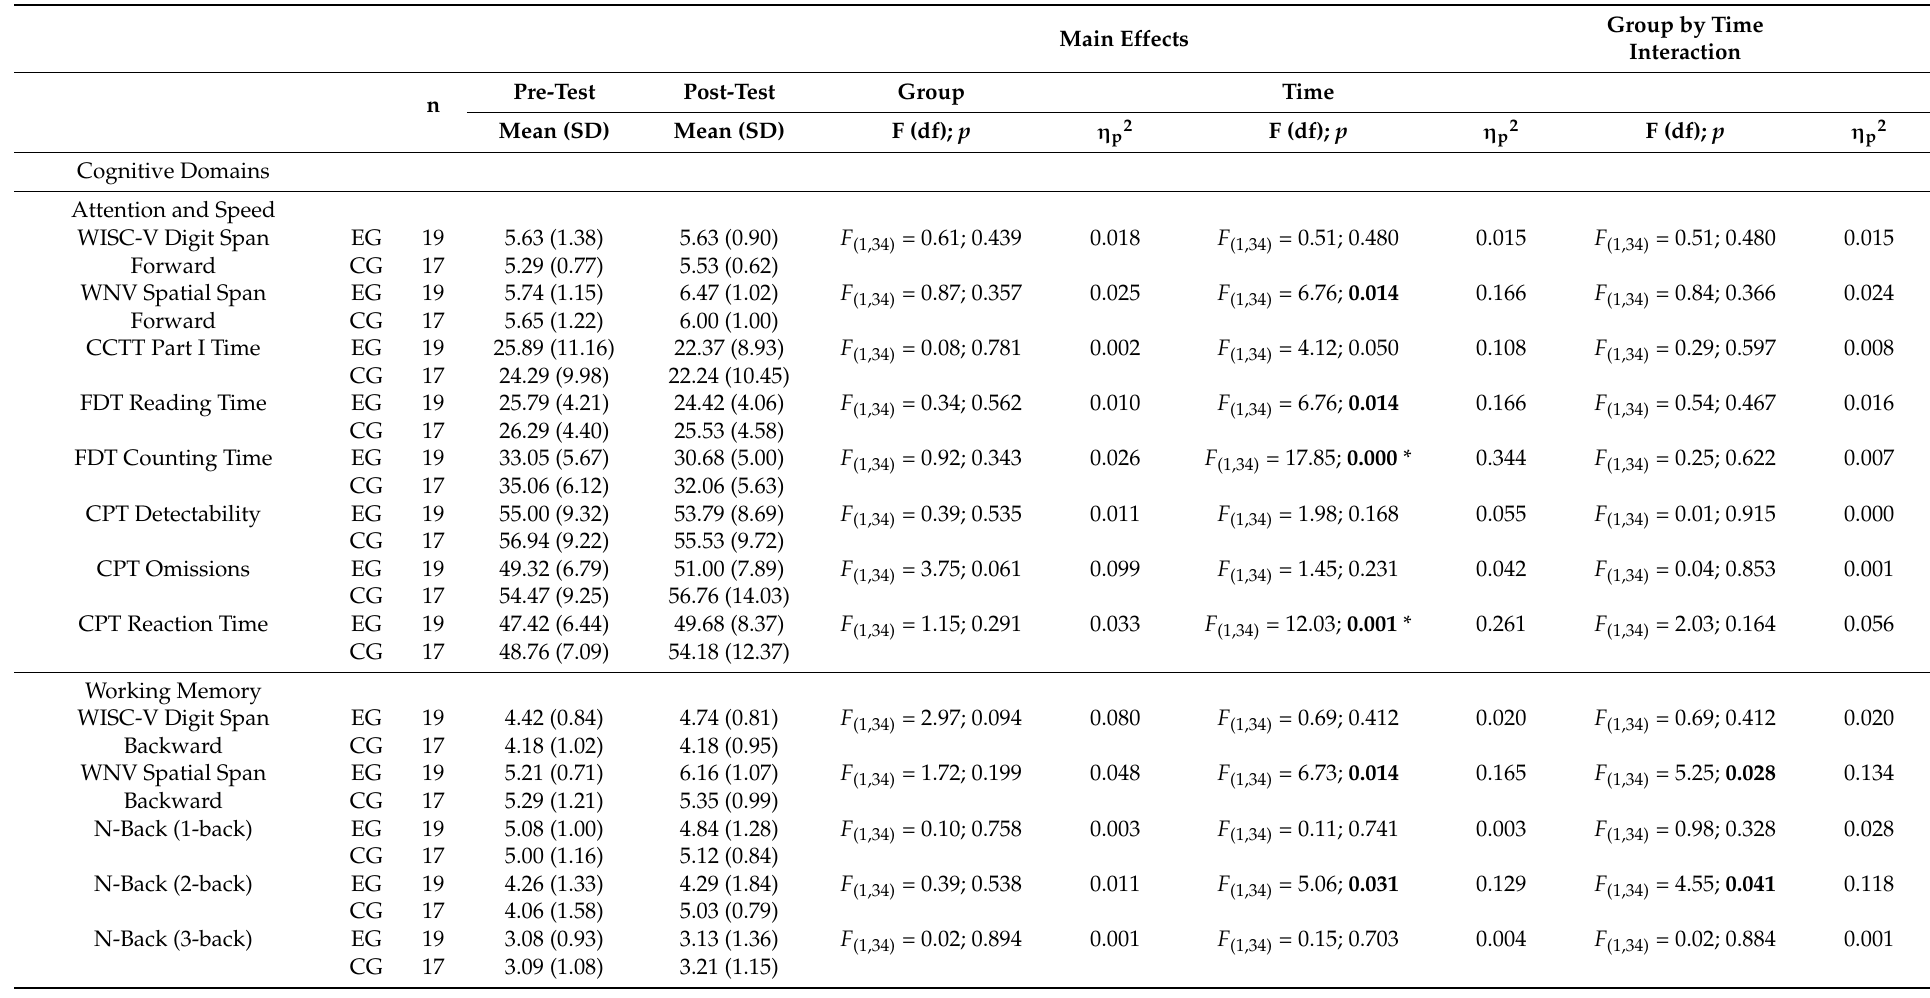
Table 3. EF training effects on secondary outcomes: post hoc analyses of cognitive